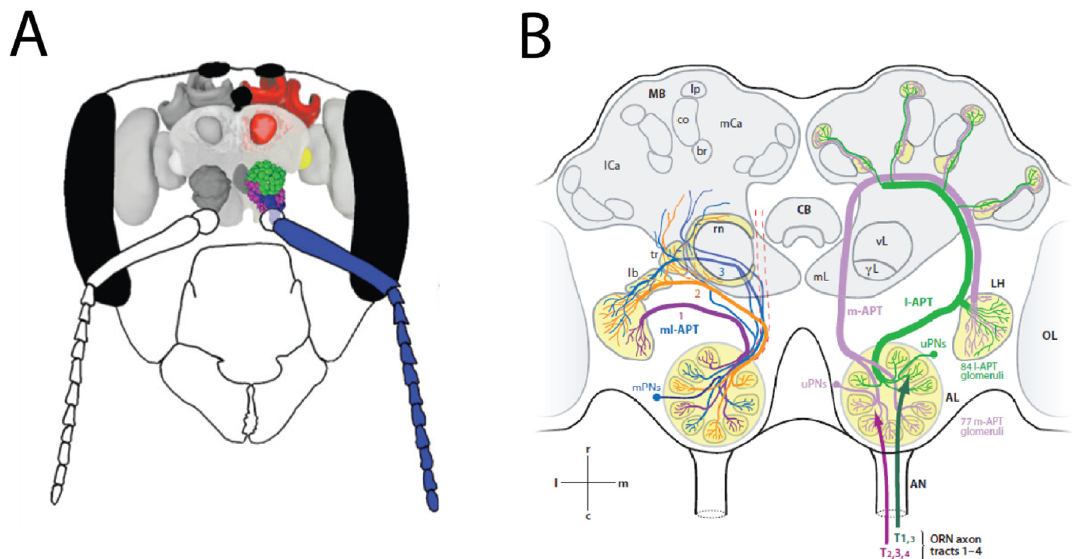
Figure 4. Olfactory coding in the honeybee neural system ( A ): Overview of the honeybee olfactory system in a schematic head capsule, with the main olfactory organs and areas (antenna (blue), antennal lobe (green and purple), lateral protocerebrum (yellow), mushroom body (red)), reprinted from [103] ( B ): Schematic overview of the dual olfactory system in honeybees, reproduced with permission from [104] 2006, John Wiley and Sons, Inc., For details, see text.